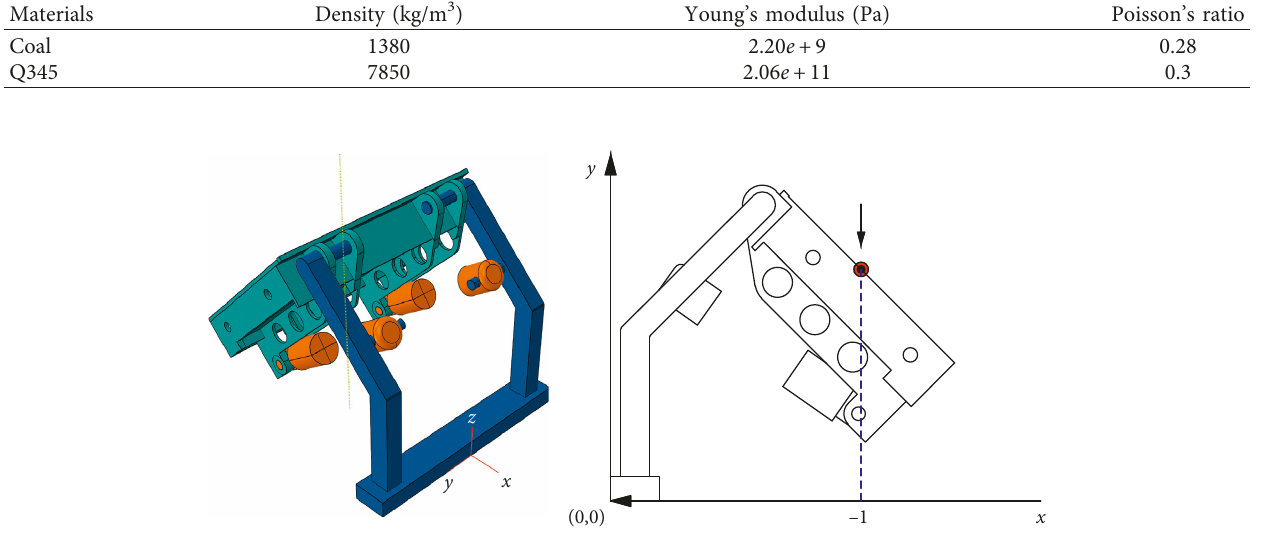
Figure 14: Impact position. Table 2: Partial simulation parameters at different impact heights.